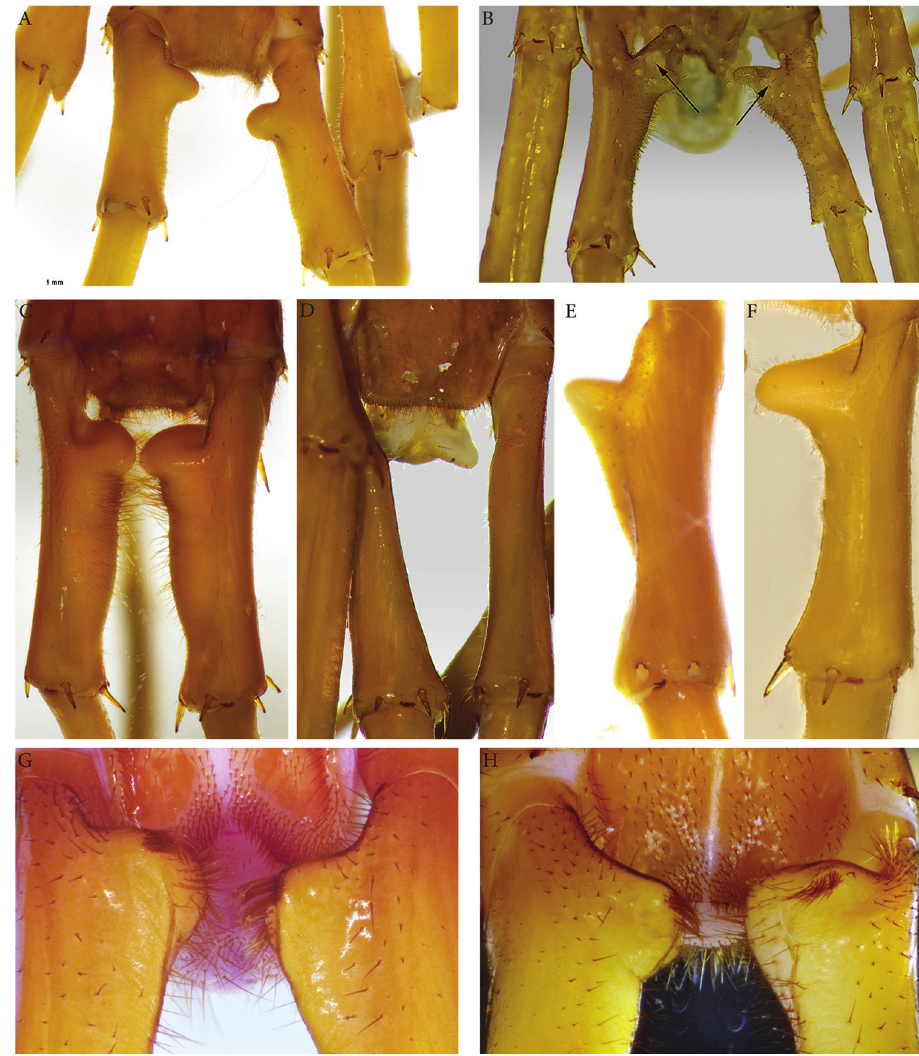
Figure 11. Prefemur of male leg 15 and intermediate tergite, dorsal view. A Eupolybothrus caesar , syntype B E. excellens C E. leostygis D E. tabularum E E. spiniger , lectotype F E. wardaranus G E. cavernicolus , male holotype H E. liburnicus sp. n., male holotype. (Figs B and D after Stoev et al. 2010 ZooKeys, https://doi.